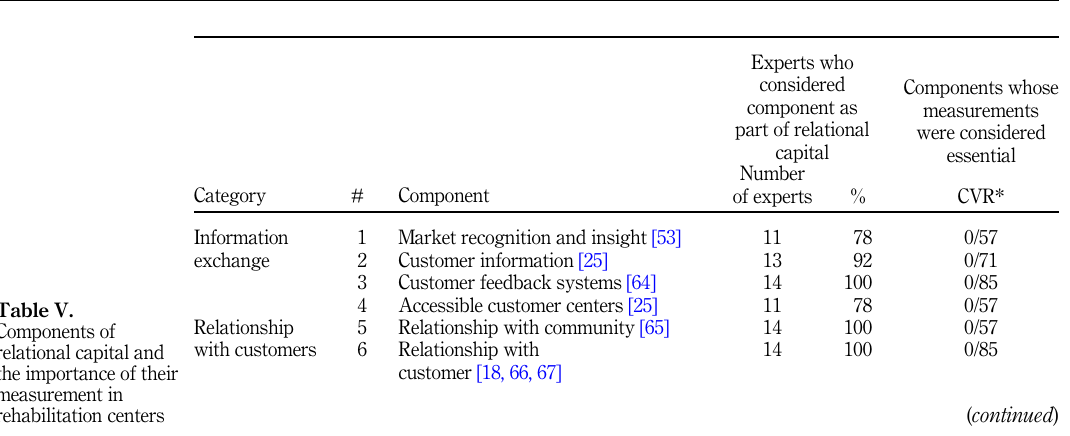
Table IV. Components of structural capital and the importance of their measurement in rehabilitation organizations